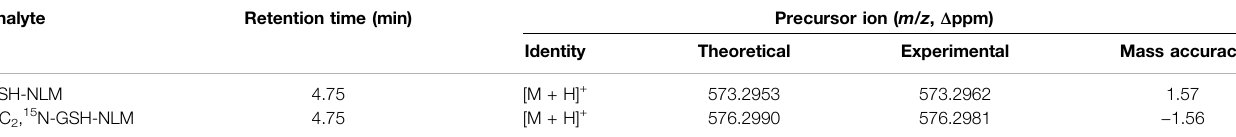
TABLE 1 | Information on the retention time and precursor ions of GSH-NLM and 13 C 2 , 15 N-GSH-NLM. Analyte